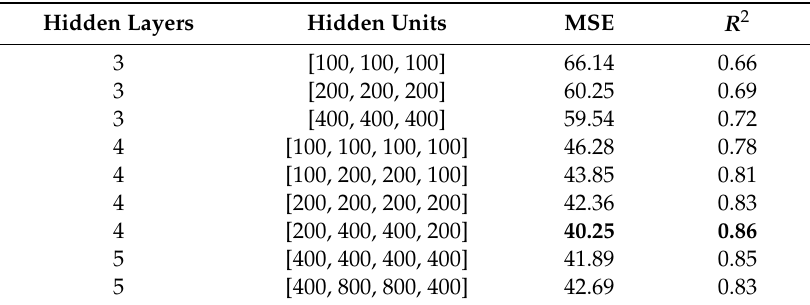
Table 2. Comparison of the structure of SAE-DNNs.